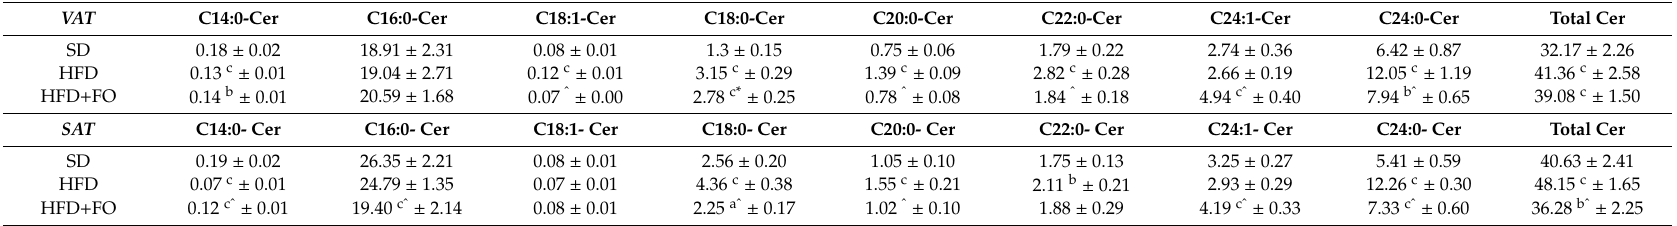
Table 3. Ceramide content in visceral and subcutaneous adipose tissue in the studied groups (pmol / mg tissue).